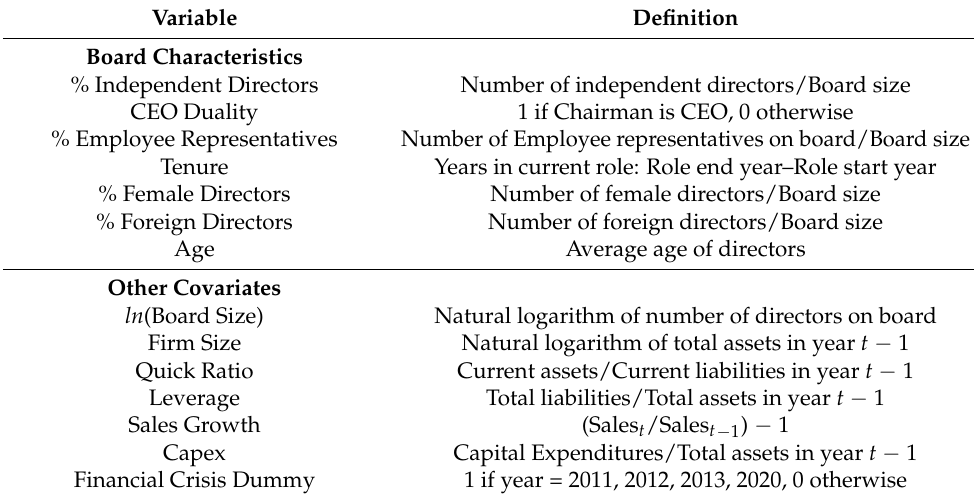
Table 1. Definitions of Board and Firm